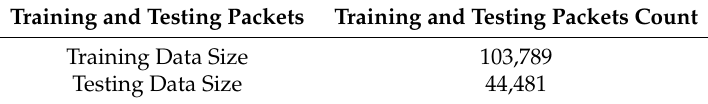
Table 5. NSLKDD dataset binary classifications total